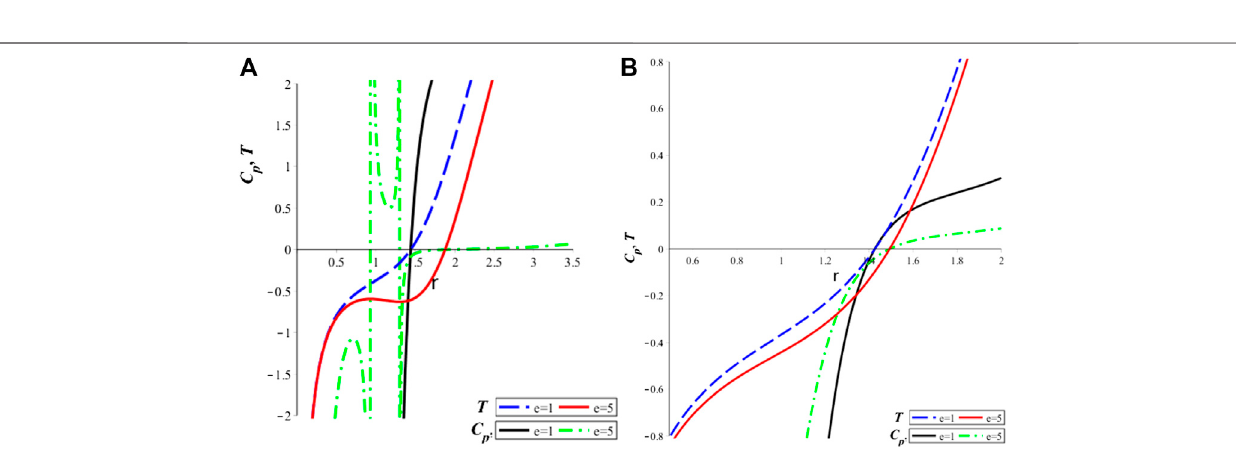
FIGURE 7 | Thermal stability with respect to r + for different values e and q with (cid:5) μ 2 (cid:1) 0 . 1, (cid:5) μ 3 (cid:1) 0 . 2, (cid:5) μ 4 (cid:1) 0 . 001, k (cid:1) 1 and n (cid:1) 4 (A) Yang-Mills quasitopological, (B) Maxwell quasitopological.